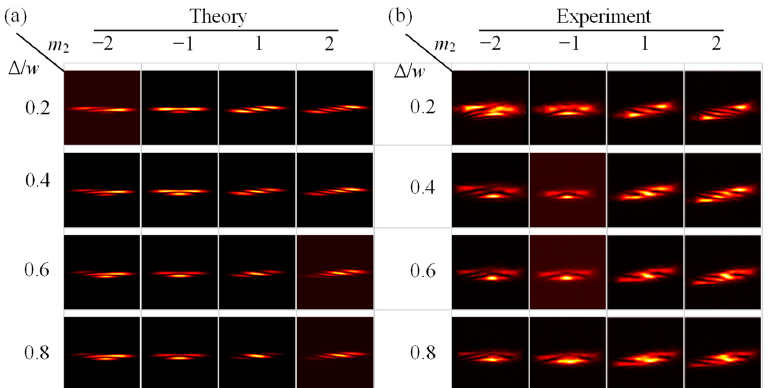
Figure 7. ( a ) Theoretically simulated and ( b ) experimentally measured intensity patterns of off-axis double vortex beams with different values of Δ and m 2 focused by a tilted convex lens when λ = 1064 nm, w = 2.5 mm, f = 30 cm, z 0 = 50 cm, z = 28 cm, θ = 21°, x 1 = x 2 = 0, and m 1 = 1.